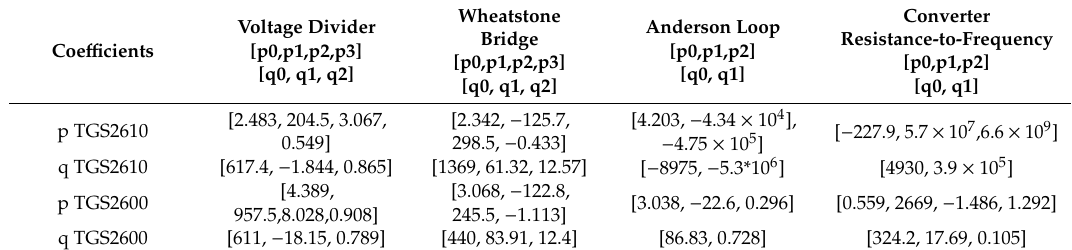
Table 3. Coe ffi cient of determination of model of each